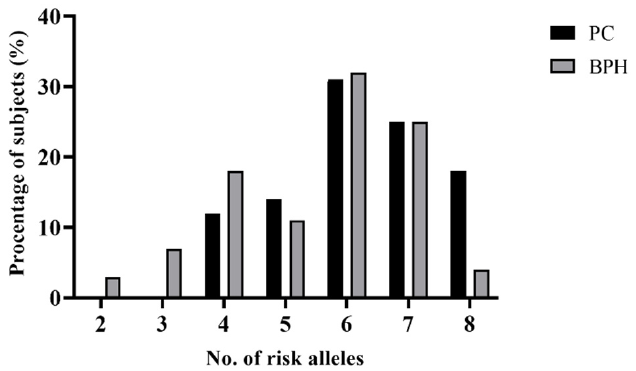
Figure 1. Distributions of risk alleles among patients with PC and BPH. The risk for PC increased significantly with the number of risk alleles (Figure 2). The total risk of PC given by the combination of these four genetic variants was increased to 52%. Therefore, individuals carrying all eight risk alleles of the four SNPs tested had a 1.5-fold increased risk for developing PC compared with the BPH group (OR = 1.49, 95%CI: 1.11–2.10, p = 0.0058).